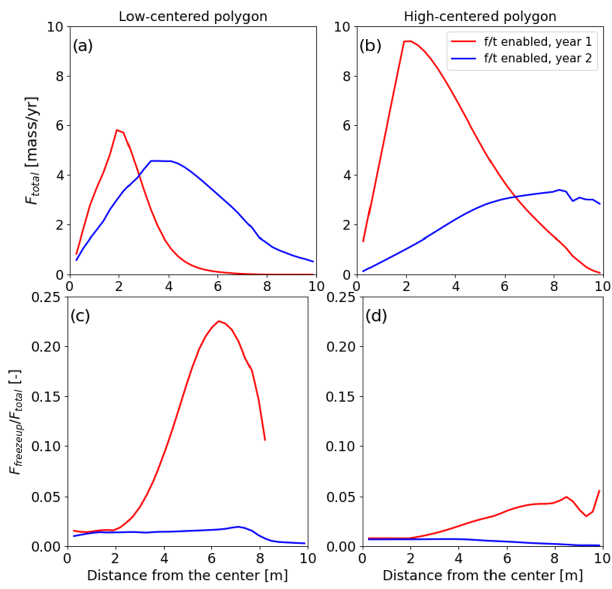
Figure 5. The low-permeability setup. The total flow rate ( F total ) represents the tracer flow rates integrated over the vertical cross- section of the polygon and over the entire year at different distances from the center of the (a) low-centered and (b) high-centered poly- gon. The proportion of tracer flow rate during the freeze-up period relative to the total flow rate at different distances from the center of the (c) low-centered and (d) high-centered polygon. F freezeup repre- sents the tracer flow rates integrated over the vertical cross-section of the polygon and over the freeze-up period at different distances from the